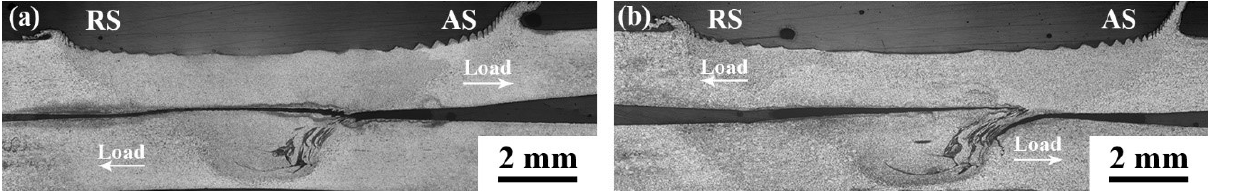
Figure 7: Fracture locations of the LA141/LA141 lap joints with two different loading modes: (a) Mode I and (b) Mode